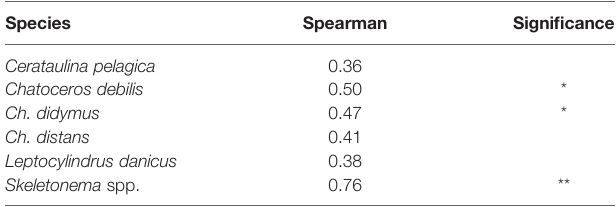
TABLE 2 | Correlations between the integrated abundance of the vegetative cells (cells m -2 ) in the water column and the emergence fl ux (cells m -2 day -1 ) revealed by the Spearman ’ s rank